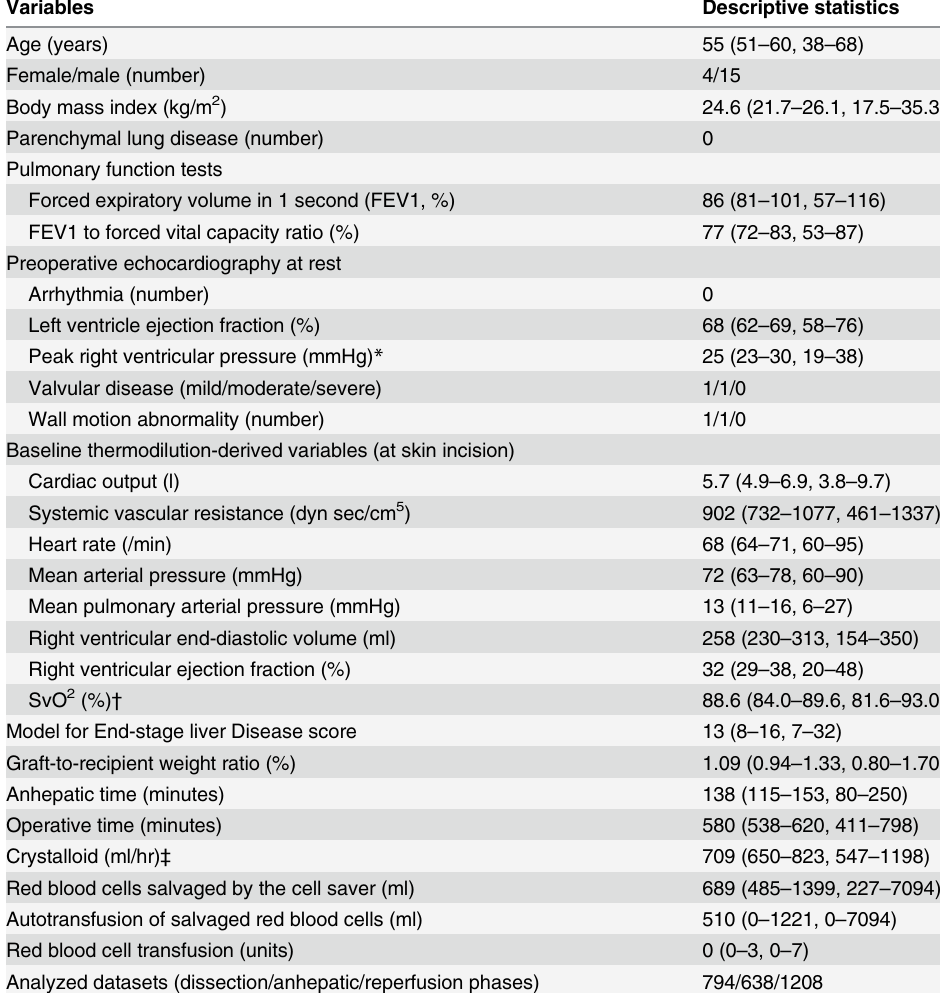
Table 1. Preoperative and intraoperative clinical data of liver transplant